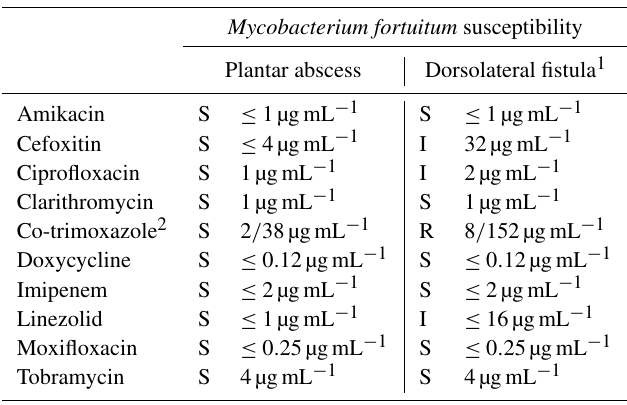
Table 1. Antimycobacterial susceptibility testing and results determined by manual microdilution from cultures obtained from the debride- ment of the plantar abscess and the subsequent fistula on the dorsum of the foot.